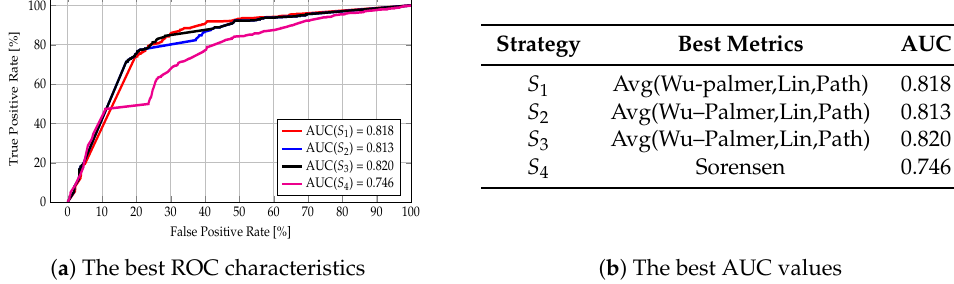
Figure 17. The best AUC values ( b ) and best ROC curves characteristics ( a ) for attribute Category .